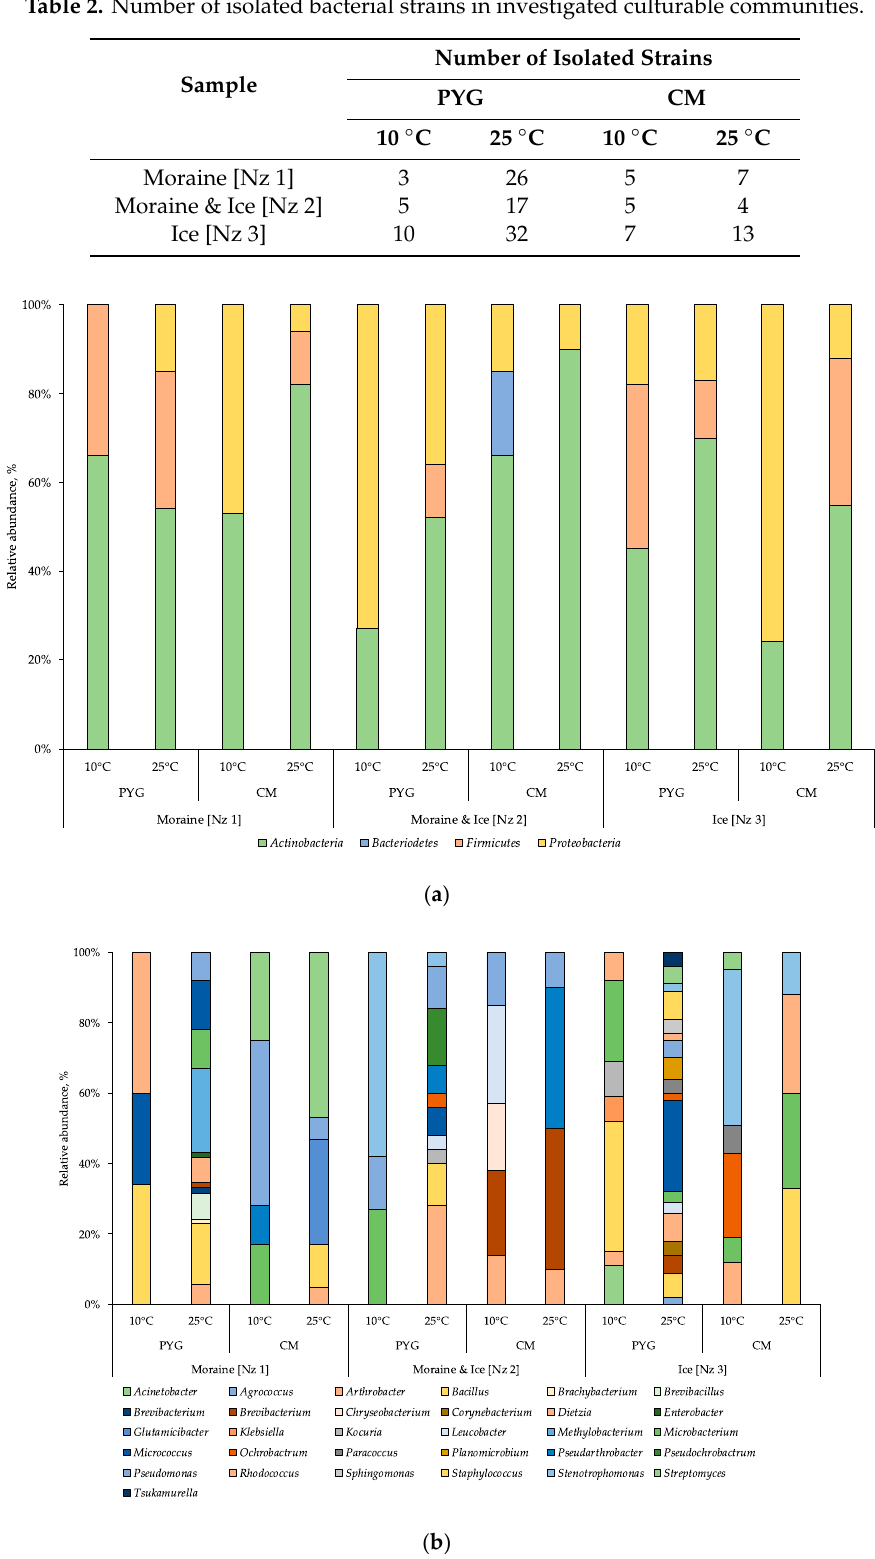
Table 2. Number of isolated bacterial strains in investigated culturable communities.